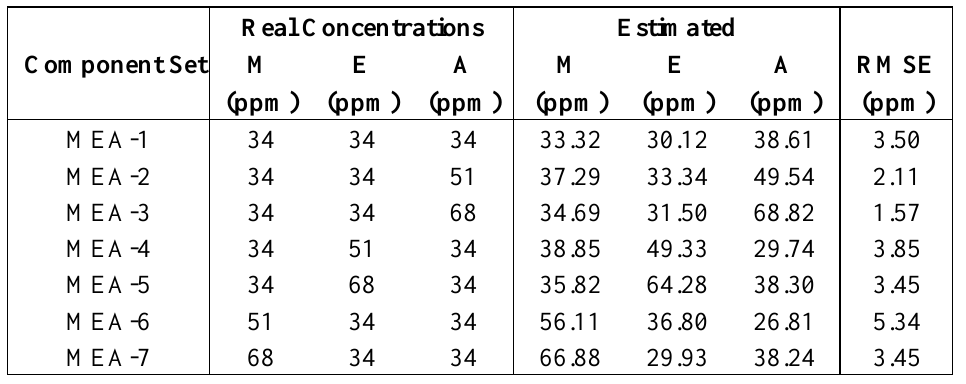
Table 7. The concentration estimation results of the proposed methodology for mixed odors with two components.